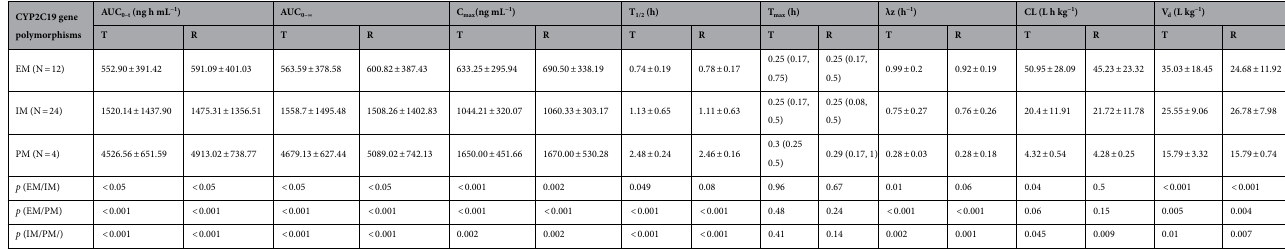
Table 3. The PK of test and reference preparation about CYP2C19 phenotypes. C max maximum blood concentration, T